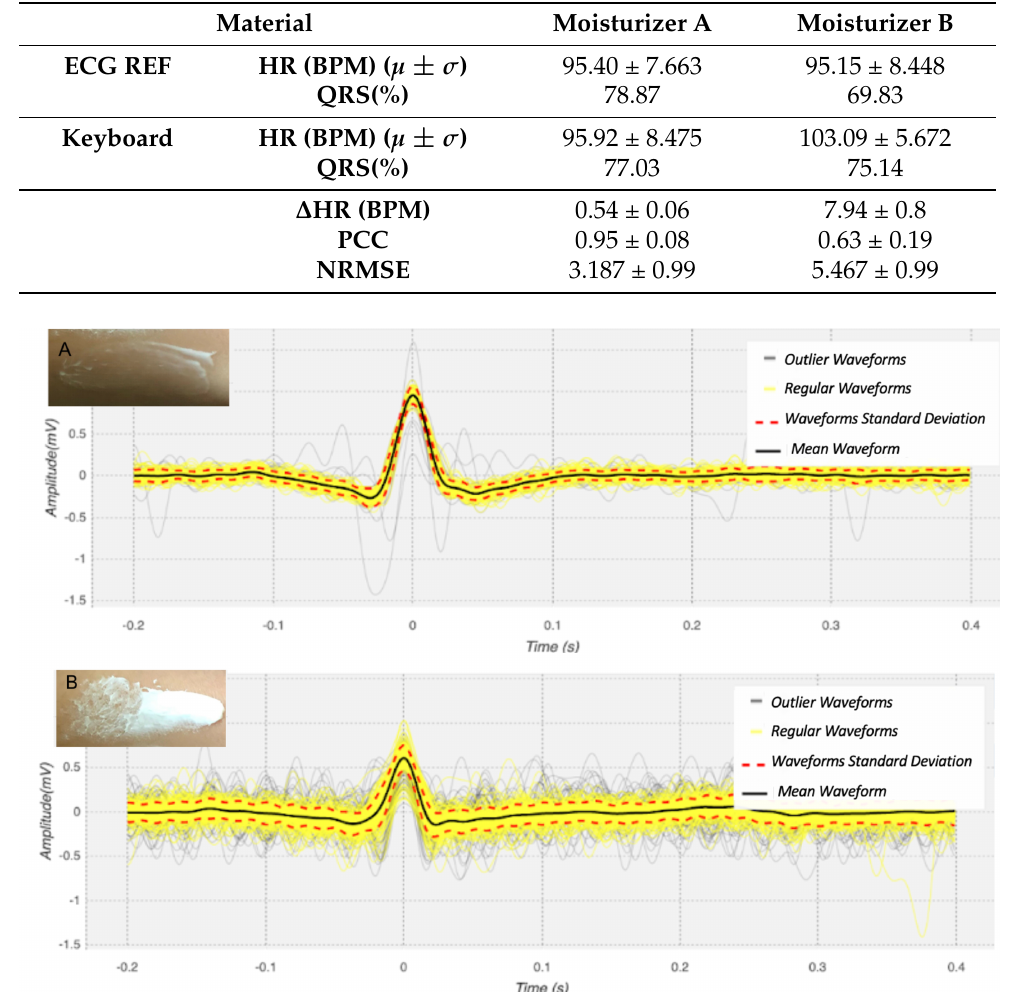
Figure 6. Example heartbeat waveforms for a test subject, obtained with the keyboard electrode when using skin moisturizersith low ( A ) and high density ( B